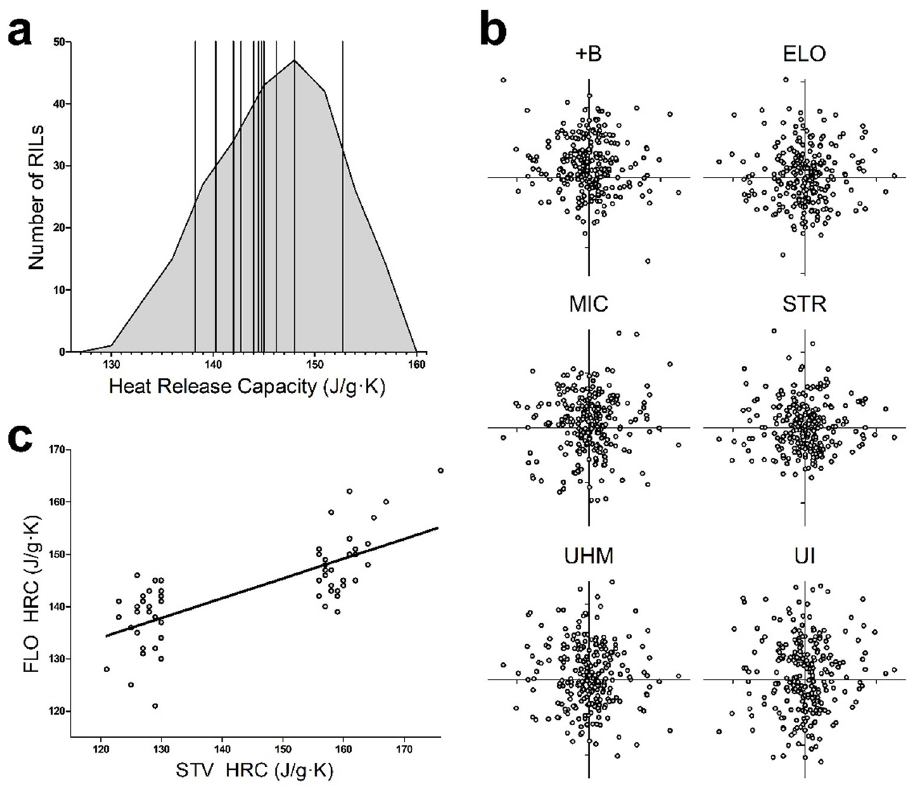
Fig 1. Heat release capacity (HRC) is a phenotype of cotton fibers measured by micro-scale combustion calorimetry. Low HRC correlates with enhanced flame resistance. (a) Histogram of HRC for 257 RILs reveals transgressive segregation. Vertical lines show the HRC values for the 11 parents of the MAGIC population. (b) HRC (x-axis) is not correlated with other fiber traits. (+B, yellowness; ELO, elongation; MIC, micronaire; STR, strength; UHM, upper half mean length; UI, uniformity index). (c) Stability of HRC at two growing locations. The screen of fibers grown at Stoneville, MS, USA (STV, x-axis) was used to select 60 outlier RILs that were grown in Florence, SC, USA (FLO,